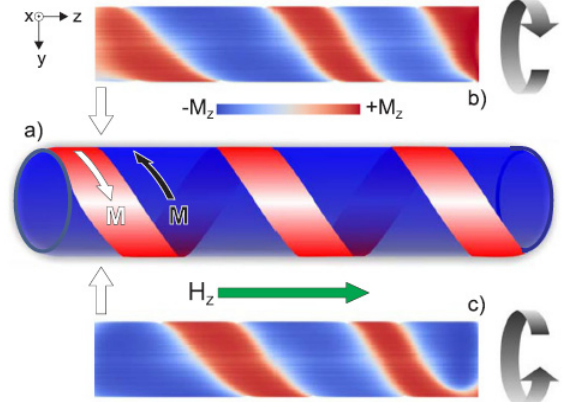
Figure 10. Result of calculation. ( a ) Schematic picture of spiral structure. ( b , c ) Plane images of the ( b ) front and ( c ) back part of the calculated structure. Reprinted with permission from [54].